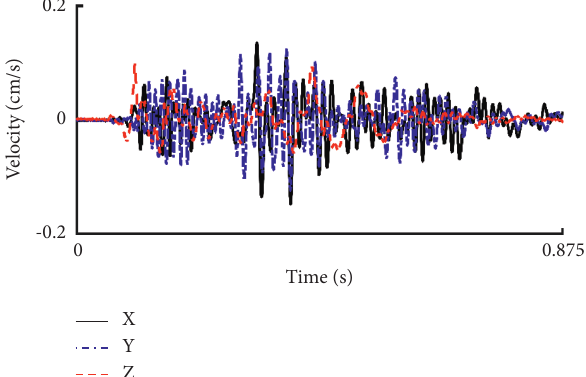
Figure 8: Time history curves of velocity of measured blasting vibrations.